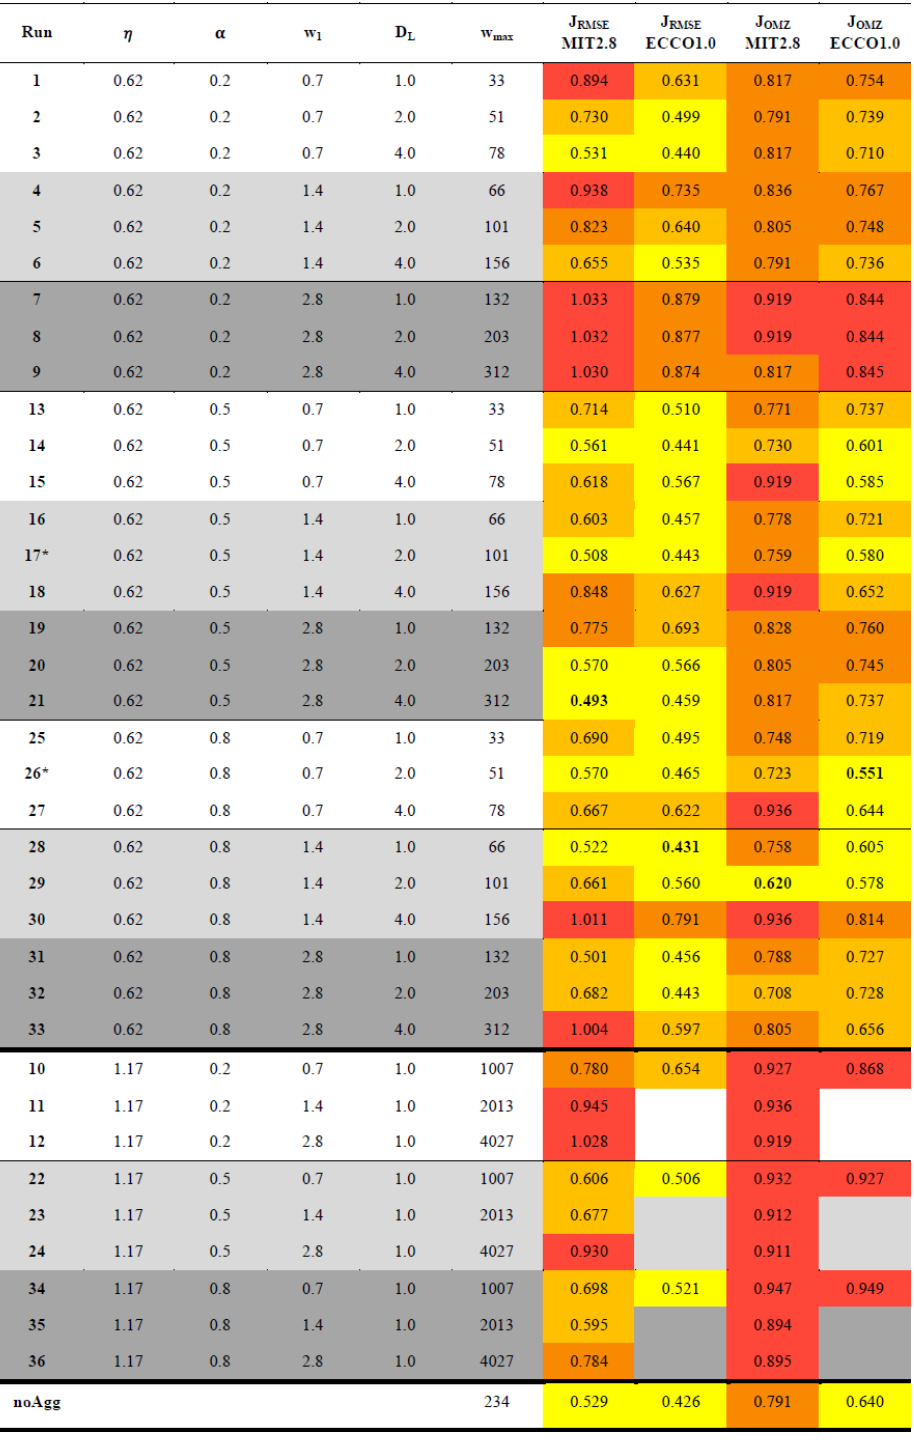
Table 1. Model runs of sensitivity study, their parameter combinations and the calculated misfit of tracers ( J RMSE ) and OMZs ( J OMZ ) for MIT2.8 and the ECCO1.0 configurations. The 25% best simulations with regard to J RMSE and J OMZ are highlighted in yellow and the ∗ ∗ worst 25% in red (relative to RMSE ECCO1 . 0 and OMZ ECCO1 . 0 ). The simulations in between are coloured in two orange gradations (bright orange is medium good and dark orange is medium bad). The best simulation of each resolution with regard to J RMSE and J OMZ is bold. OMZ is defined as 50mmolm − 3 . Parameter η denotes the exponent for size-dependent sinking, α the stickiness, w 1 the minimum sinking speed, D L the maximum diameter for size-dependent sinking and aggregation, and w max the maximum sinking velocity in the spectral